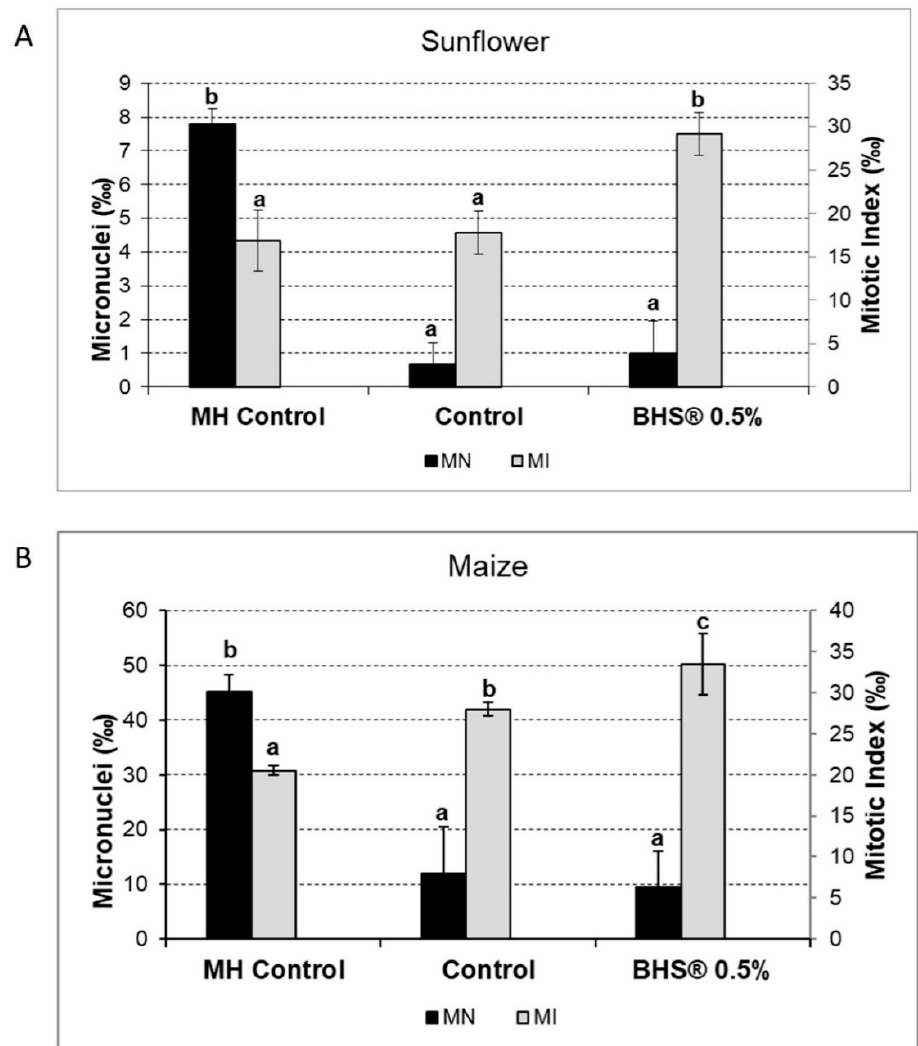
Figure 7. ( A , B ): Scoring of Micronuclei indices expressed as the number of micronuclei per 1000 cells (Left bar chart) and mitotic index, expressed as the number of dividing cells per 1000 cells (Right bar chart) observed in the root apices of sunflower (( A ) Helianthus annuus ) and maize (( B ) Zea mays ) after 56 h of treatment: non-exposed (Control) or exposed to Maleic hydrazide at 1.12 mg.L − 1 (MH Control), or to commercial products of biomimetic humic substances (BHS ® 0.5%). (Histograms marked with the same letter are not statistically different at p < 0.05).